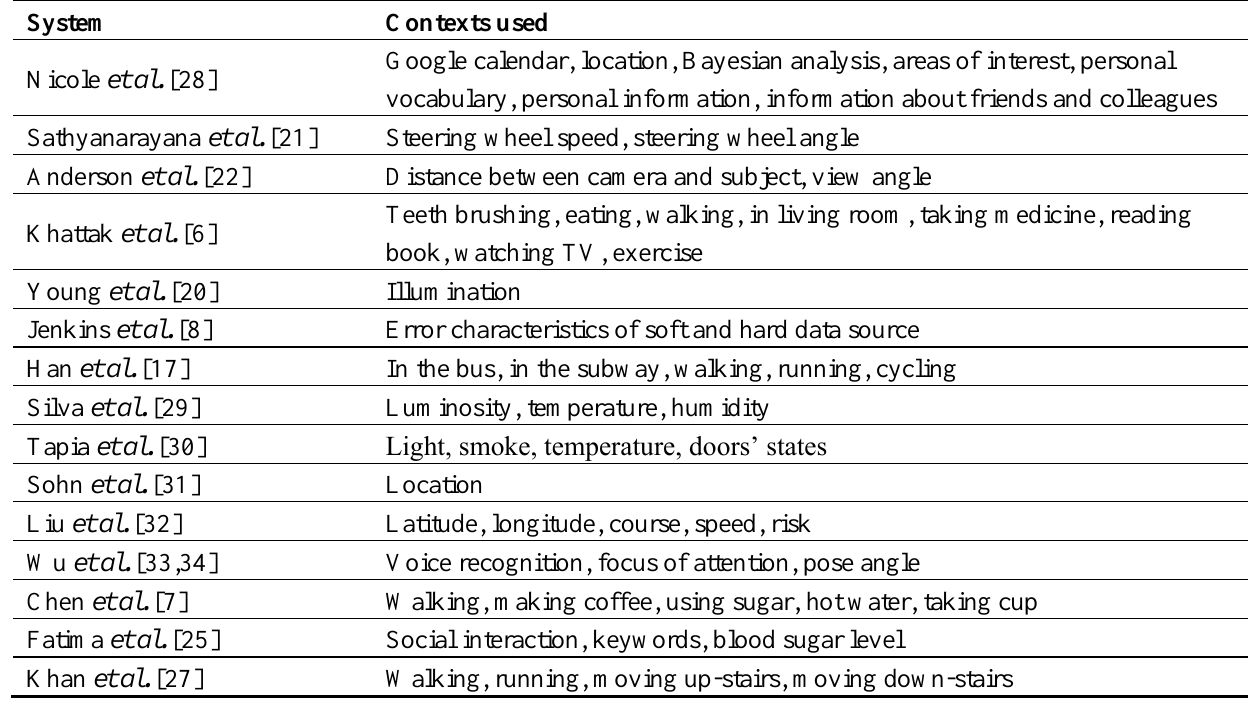
Table 2. Context captured and used by various existing context-aware